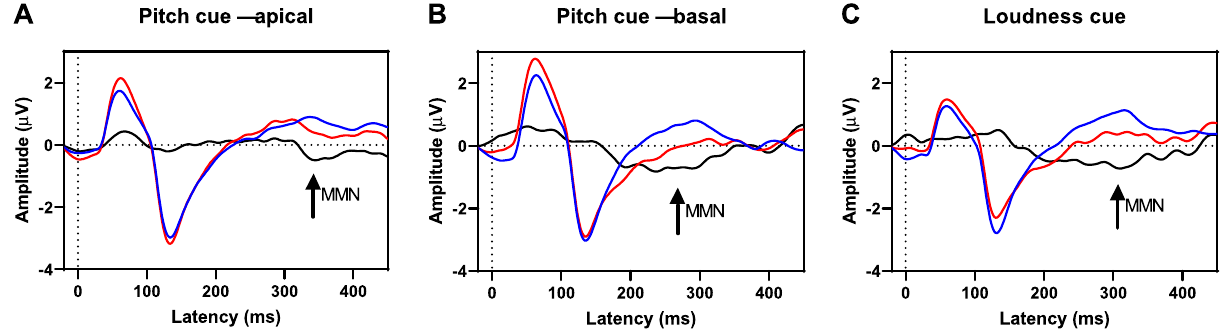
Figure 3. EEG responses for standard (blue) and deviant (red) stimulation as averages over all participants (n = 17) and over the deviance directions upward and downward. The black curve shows the deviant minus standard difference. The deviant stimuli differed from the standard stimuli in pitch at an apical CI electrode ( A ), in pitch at a basal electrode ( B ) or loudness ( C ). For pitch cues at a basal electrode and loudness cues significant differences were found and interpreted as eMMN response (arrows).